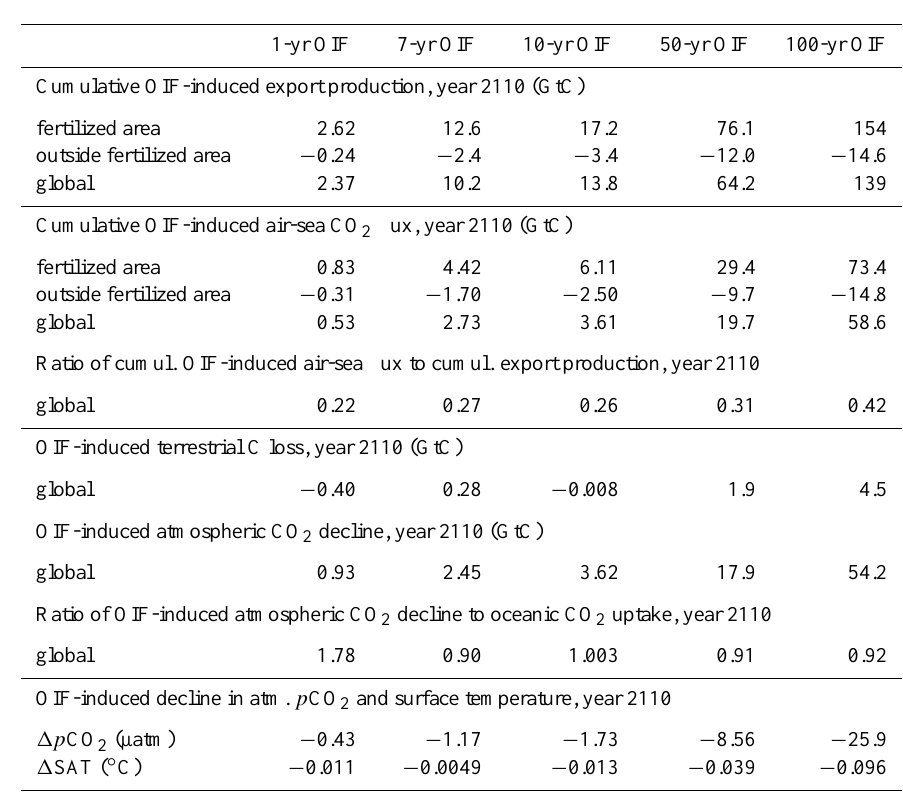
Table 1. Model results.